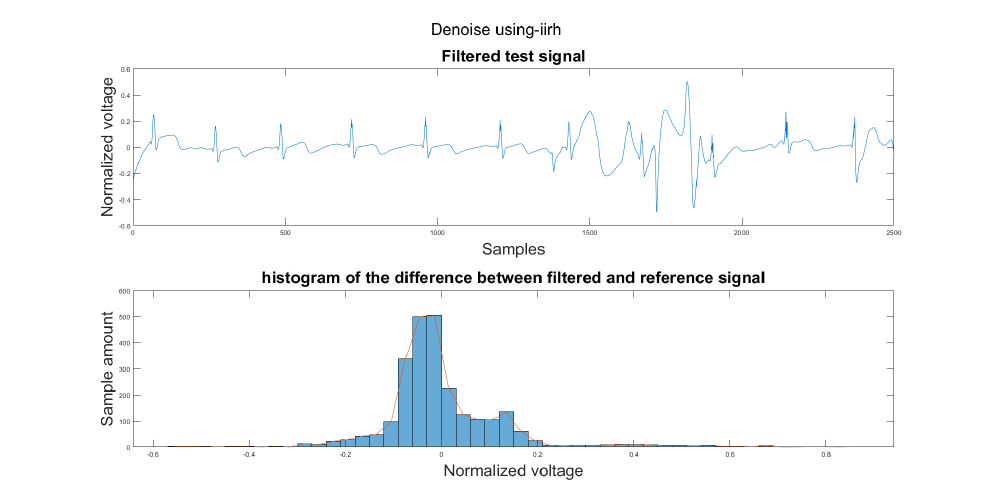
Figure A23. (1) Test signal, (2) histogram of the